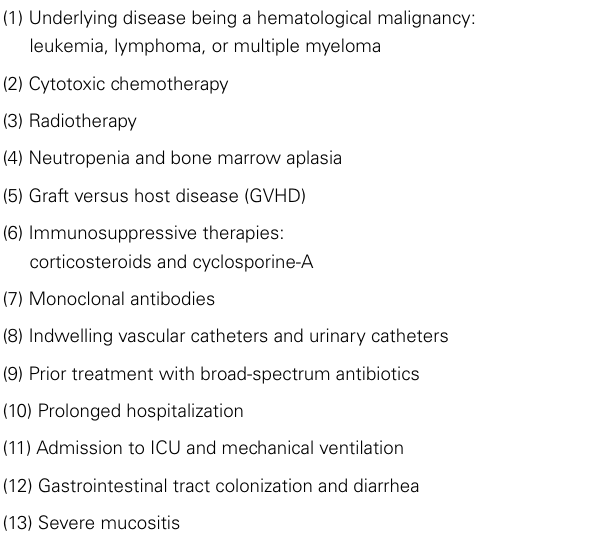
Table 2 | Risk factors for S. maltophilia infections in HSCT recipients